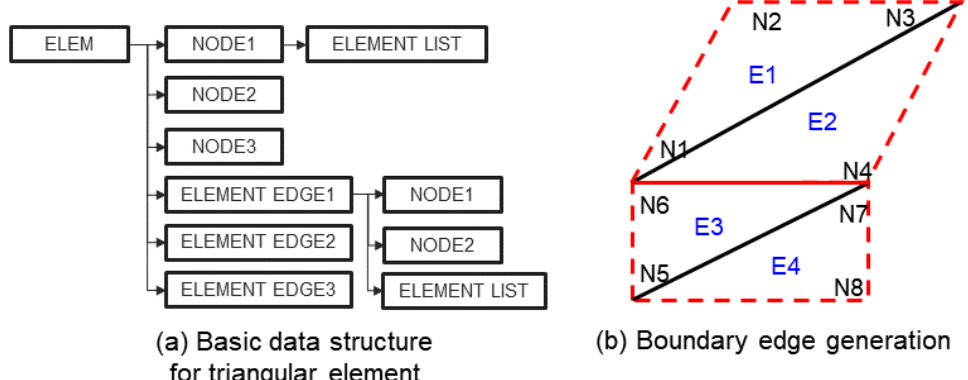
Figure 4. Generation of boundary edges from triangular elements.